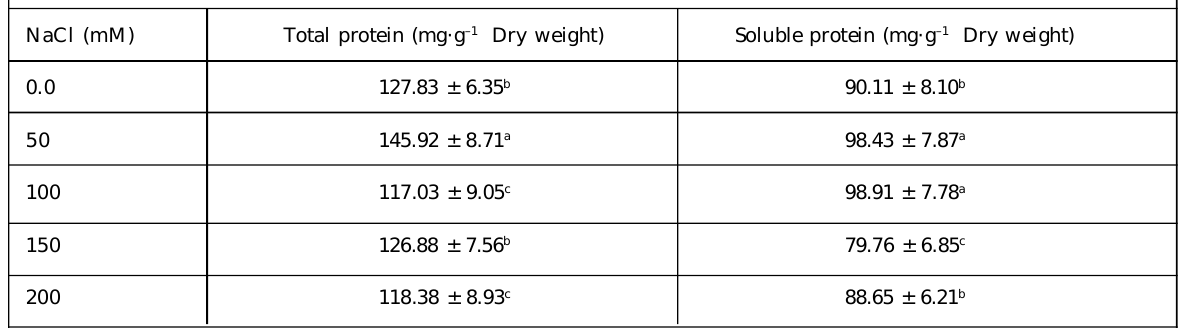
Table 6: Impact of different concentrations of NaCl on total and soluble protein contents in Phaseolus vulgaris L.